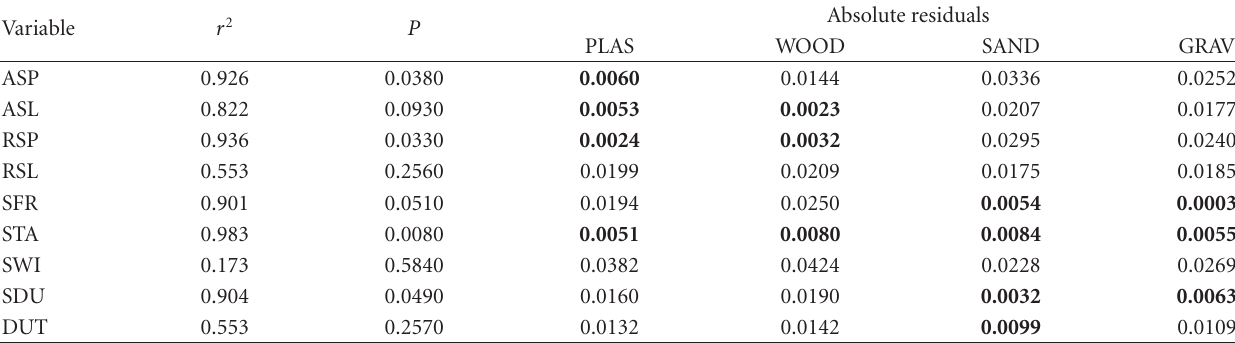
Table 3: Results of multiple linear regression of log-transformed relative speed (RSP) versus log-transformed relative stride length (RSL) and stride frequency (SFR) for each substrate (codes as in Table 1). The coe ffi cients of determination ( r 2 ) were shown, as well as the intercepts ( a ) and the partial regression coe ffi cients ( b 1 for RSL, b 2 for SFR), with respective t tests and P values. β is standardized partial regression coe ffi cients for each variable. Sample size for each substrate is n = 72. Only for WOOD the partial regression coe ffi cients for both RSL and SFR di ff ered significantly in pairwise comparisons among substrates.